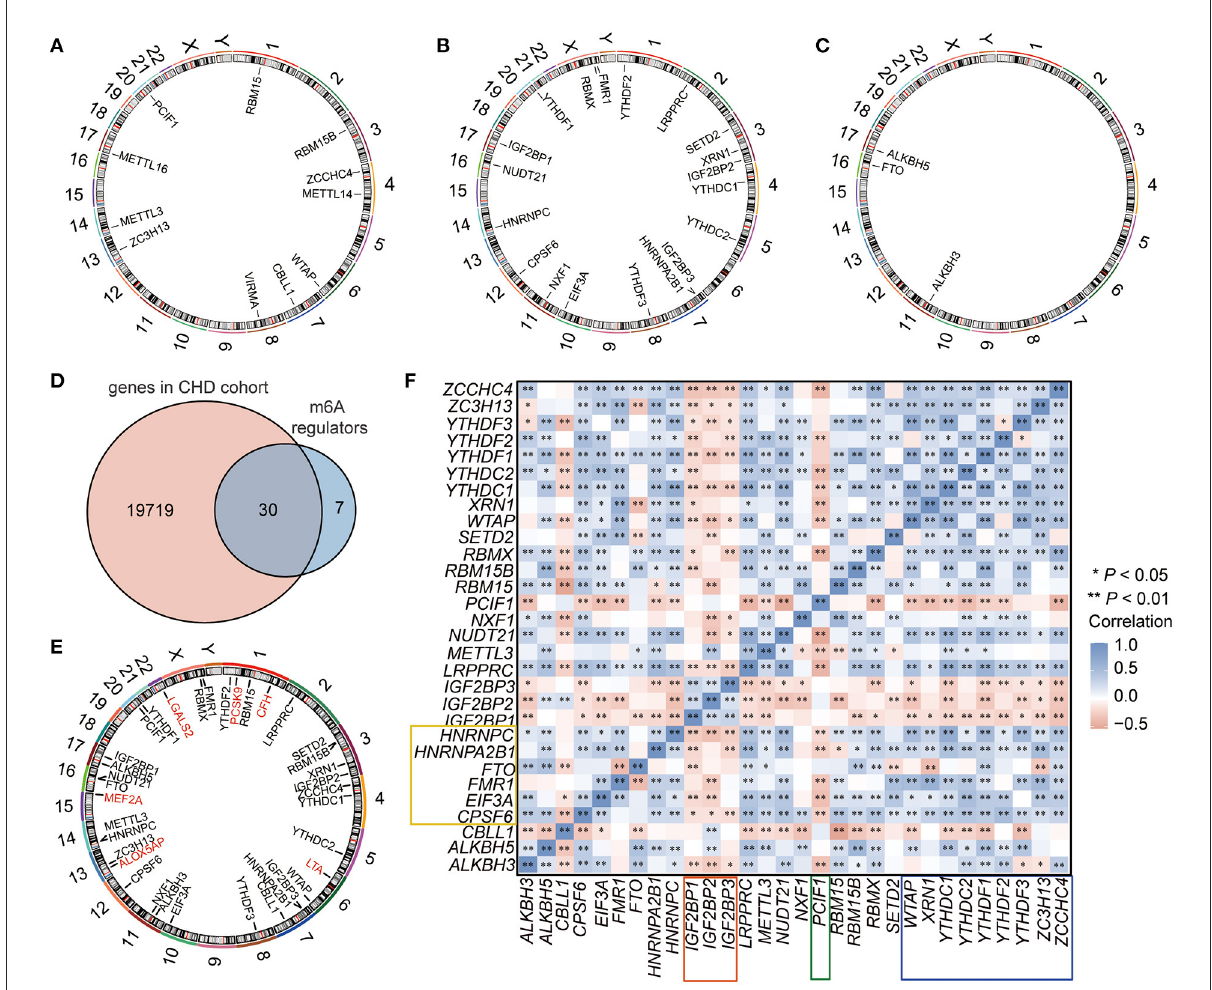
FIGURE2 The landscape of m6A regulators in CHD. (A–C) The location of m6A RNA methylation writers (A) , readers (B) , and erasers (C) on the chromosome. (D) Venn showing the overlapped m6A regulators in the GEO-CHD cohort. (E) The location of m6A regulators and the CHD susceptibility genes. The red labeled genes were CHD susceptibility gene, and the black labeled genes were m6A regulators. (F) The correlation of the m6A regulators in CHD.